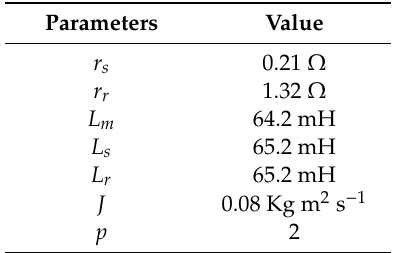
Table 5. Parameters of the Induction